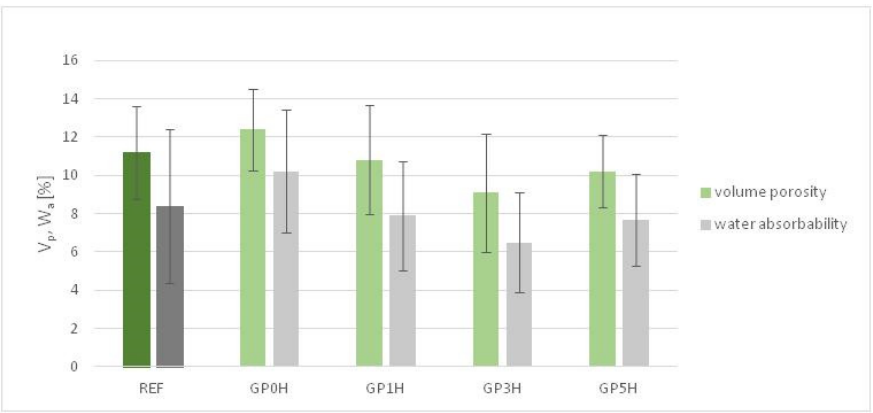
Figure 5. Changes in porosity and water absorption in granite powder pastes with respect to a reference sample.